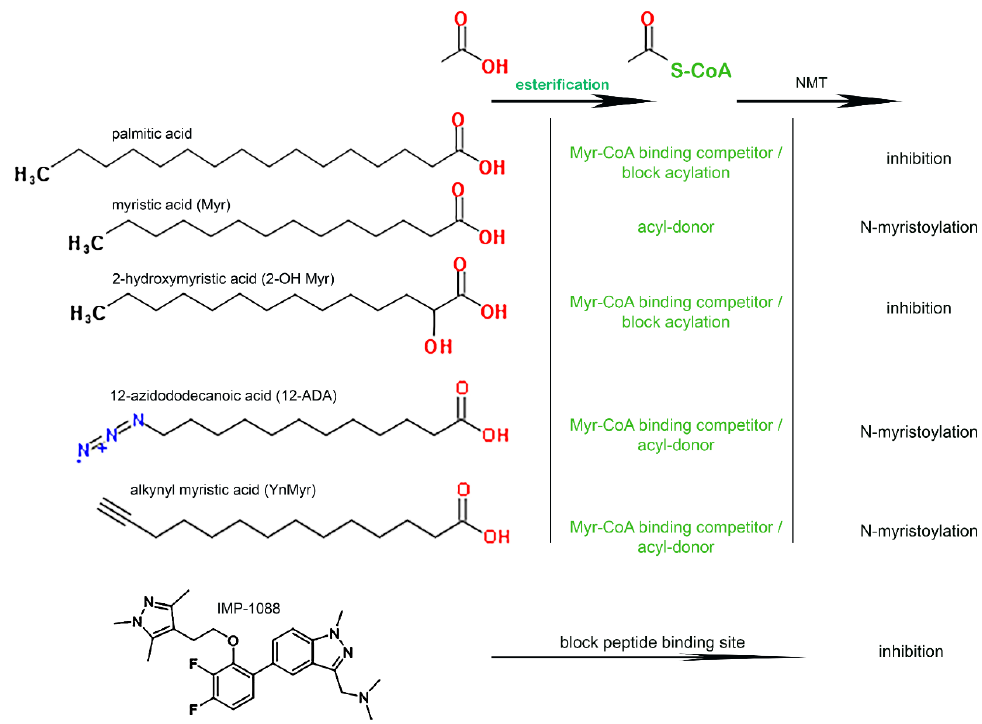
Figure 2. Compounds affecting NMT activity and their precursors. The fatty acids palmitic acid (C 16:0 ), myristic acid (C 14:0 ), 2-hydroxymyristic acid (2-OH C 14:0 ), 12-azidododecanoic acid (12-ADA)